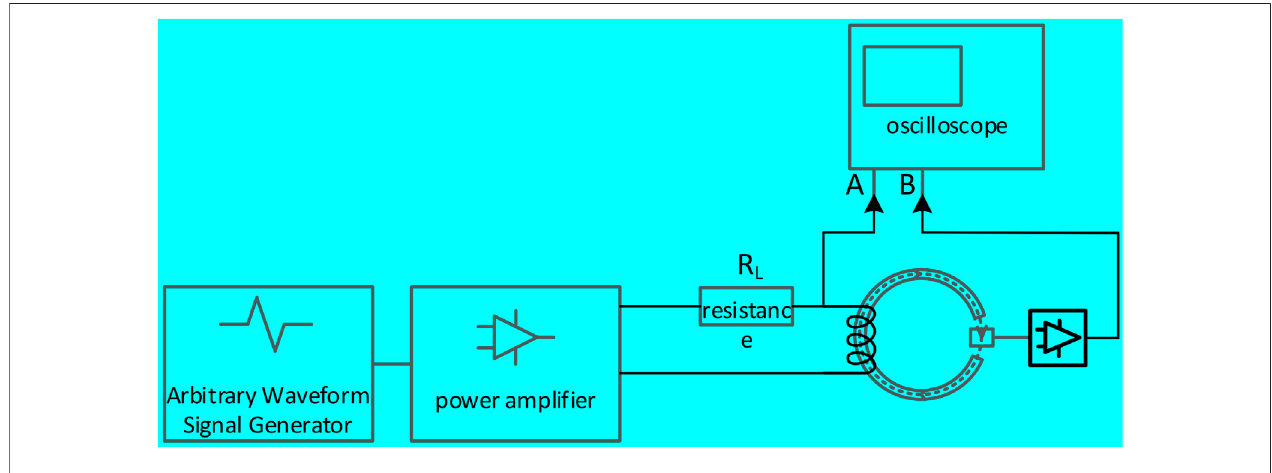
FIGURE 4 | Test principal